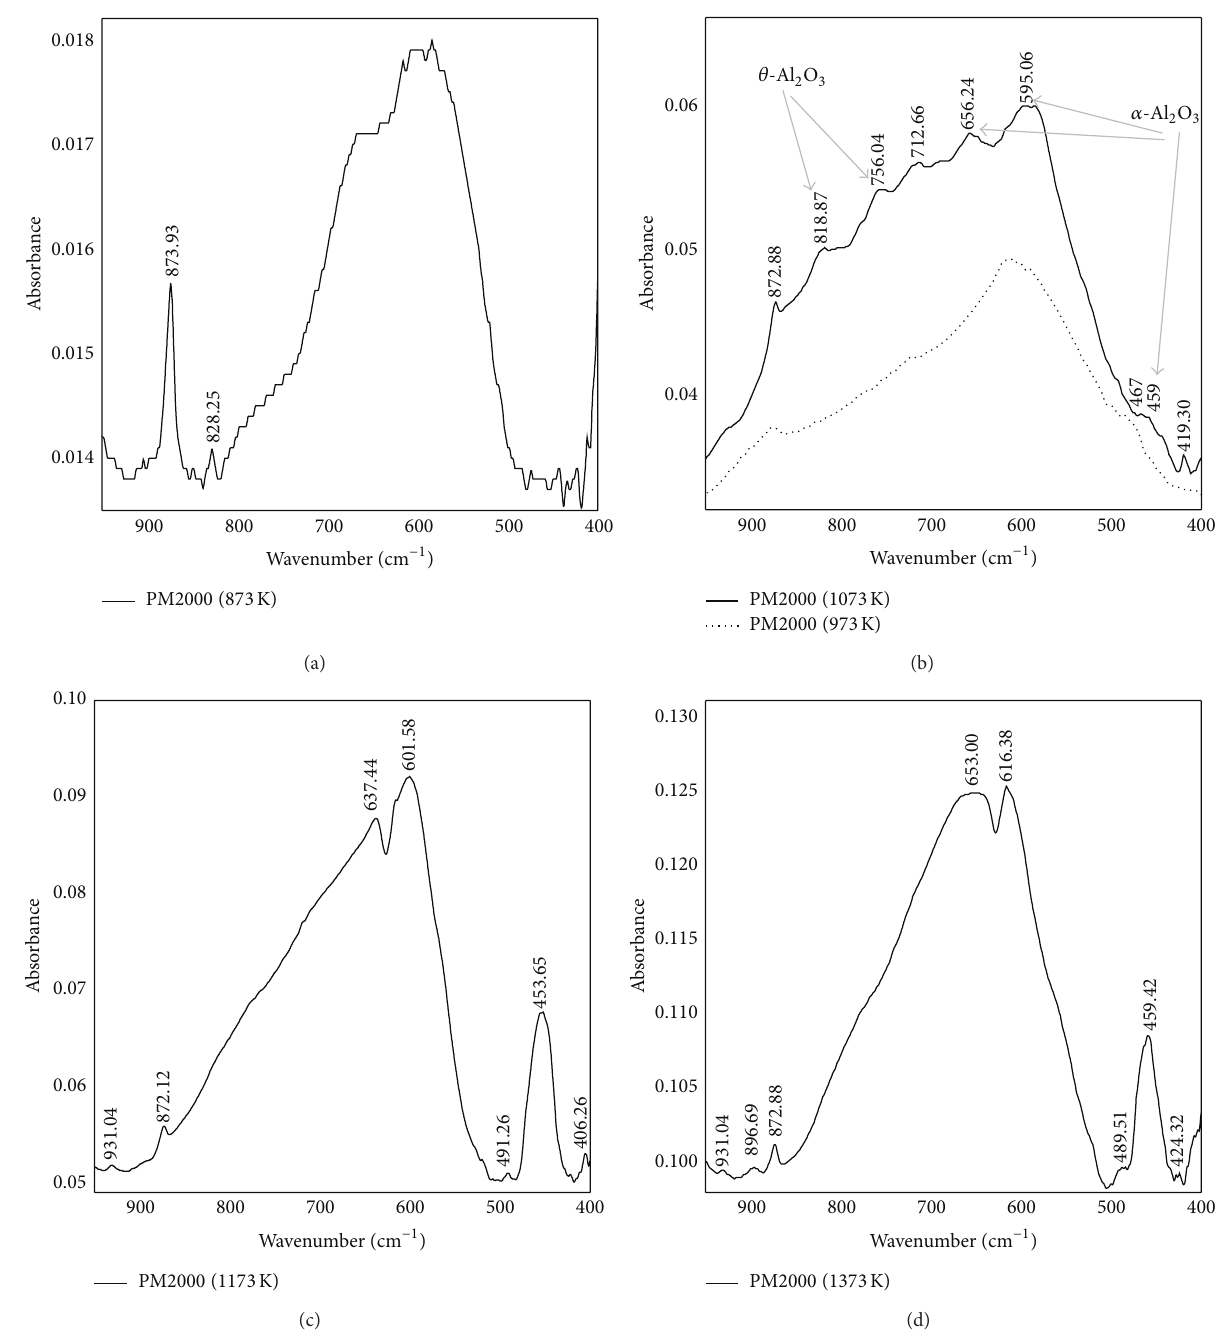
Figure 6: FTIR spectra of oxidized PM2000 at 873 K (a), 973 K and 1073 K (b), 1173K (c), and 1373 K